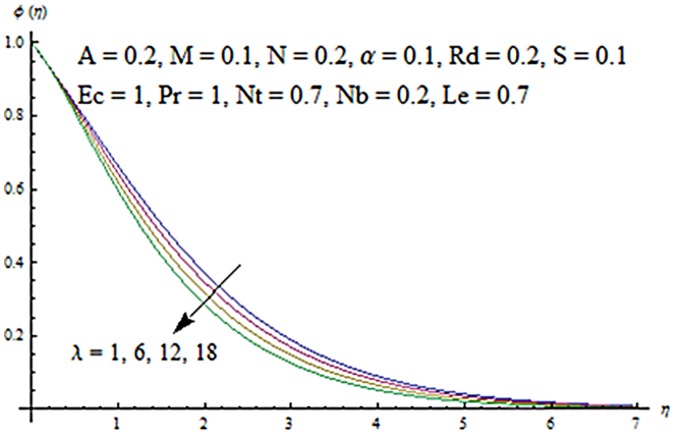
Influence of λ on ϕ.